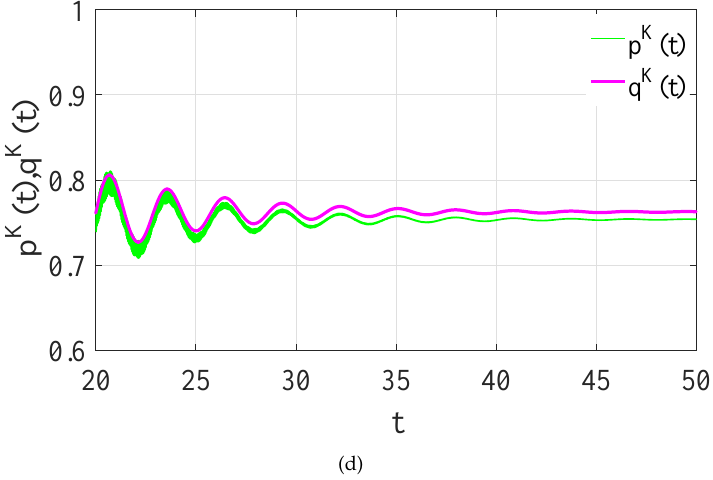
Figure 4. State trajectories of systems (16) and (17) under controller (5) when γ = 0.98. ( a ) p R ( t ) and q R ( t ) ; ( b ) p I ( t ) and q I ( t ) ; ( c ) p J ( t ) and q J ( t ) ; ( d ) p K ( t ) and q K ( t ) .